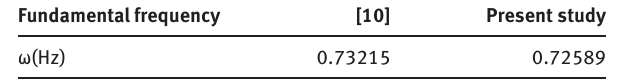
supported cross ply (0 ° /90 ° ) square spherical shell.